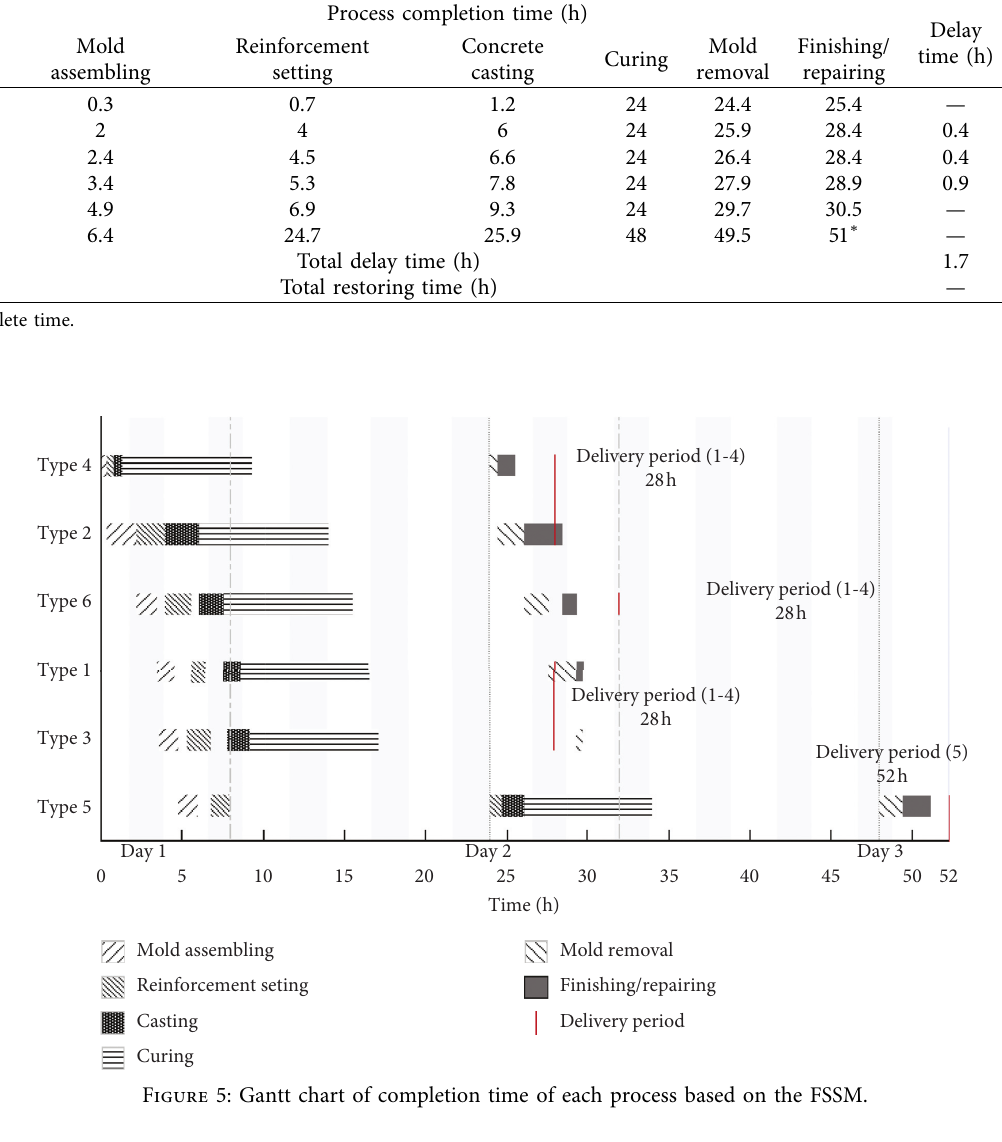
Table 3: Completion time of each process based on